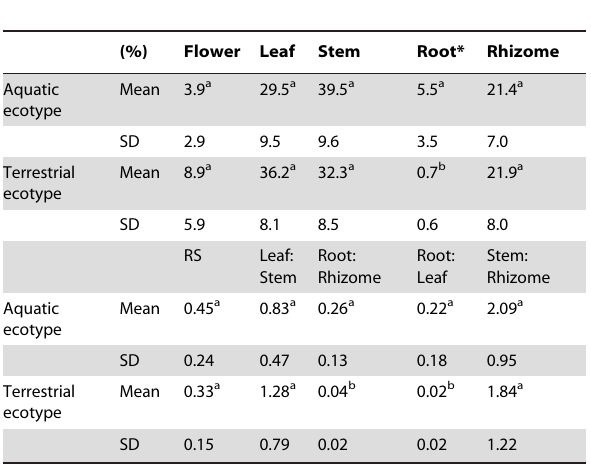
Table 2. Biomass allocations of aquatic and terrestrial reed